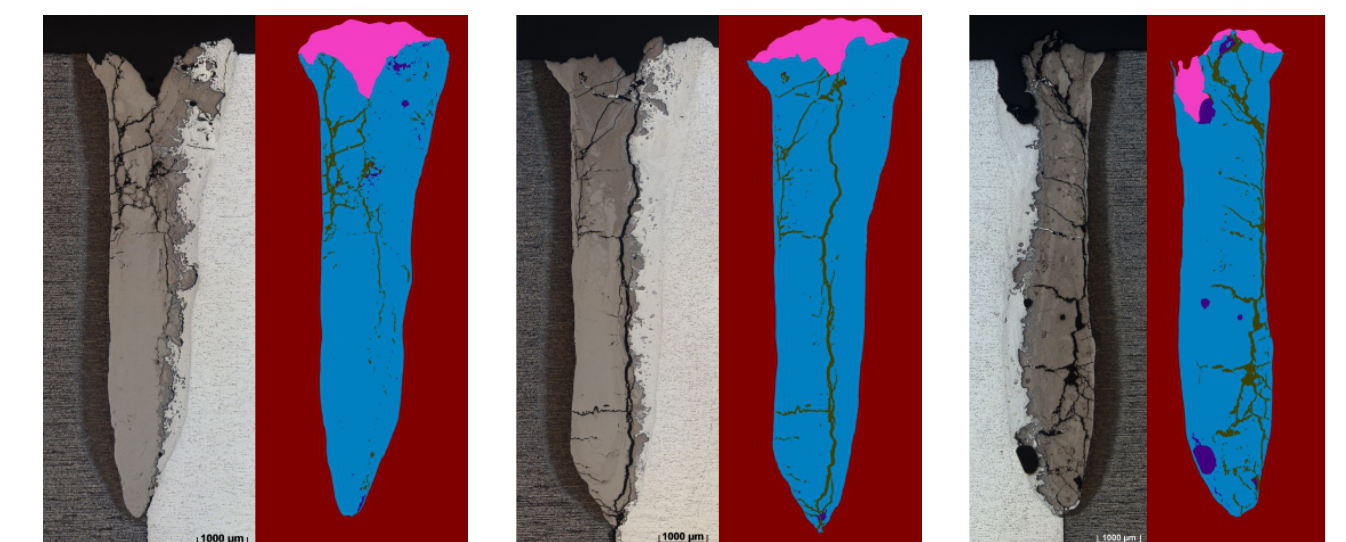
Figure 8. Segmentation